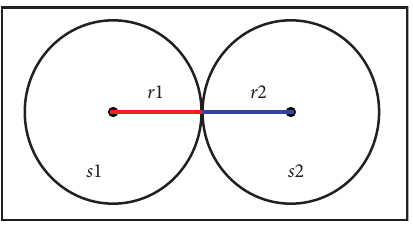
Figure 5: Adjacent sensors.